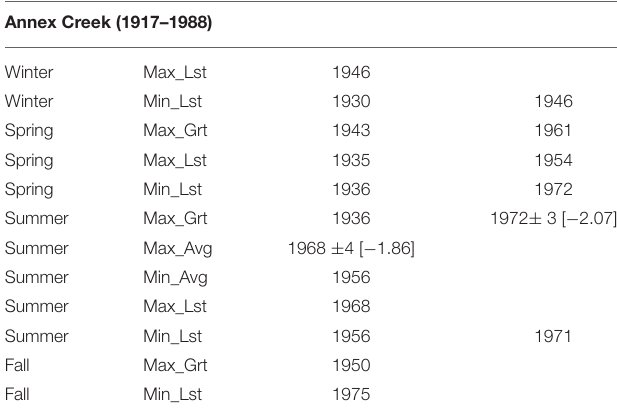
TABLE 4B | Change-points in mean for station AC of Alaska with: PELT change-point estimate ± width of approximate 95% confidence interval (when